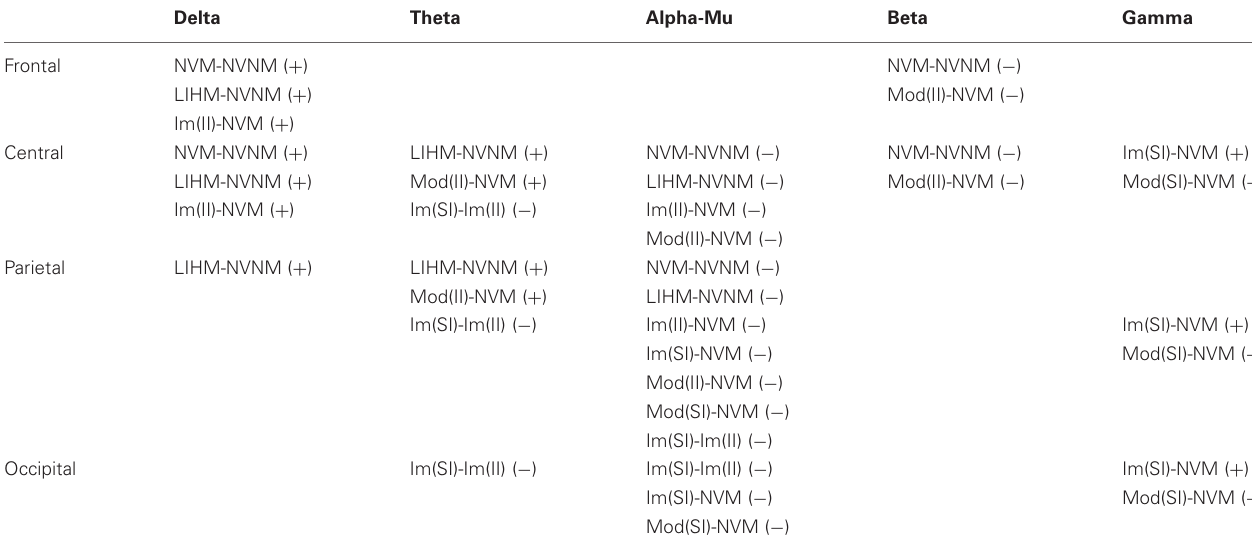
Table A1 | Summary of amplitude for delta, theta, alpha-mu, beta, and gamma frequency